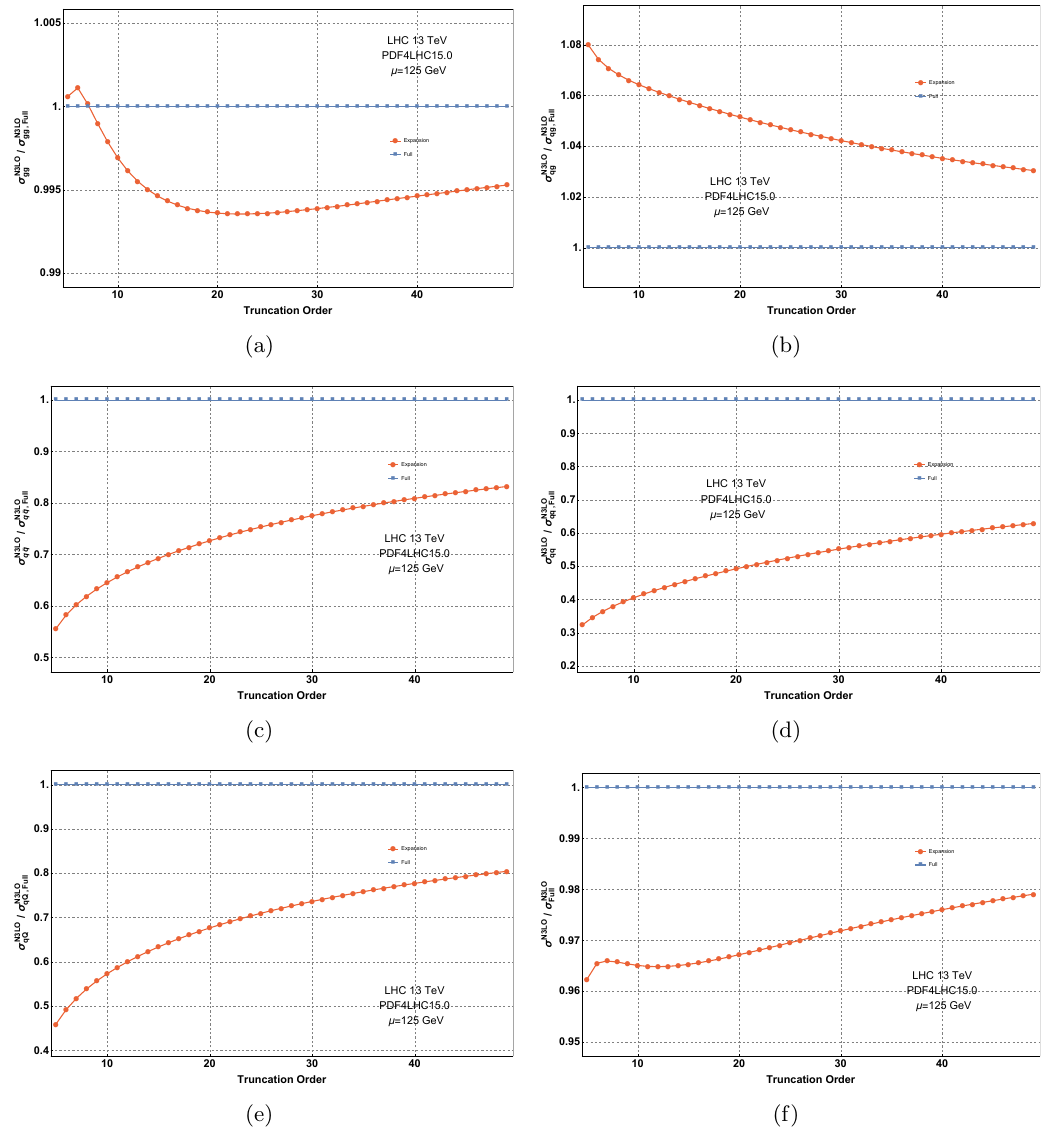
Figure 6 . The (cid:12)gure shows in red the contribution of the partonic coe(cid:14)cient function to the N 3 LO correction of the Higgs boson cross section approximated by a threshold expansion normalised to the all order result. The x-axis labels the order at which the expansion is truncated. The line in blue represents the contribution to all orders in the threshold expansion and is displayed as a reference. Figures (a), (b), (c), (d), (e) and (f) show the contribution due to the gg, qg, q(cid:22) q , qq, qQ initial state and the sum of all channels